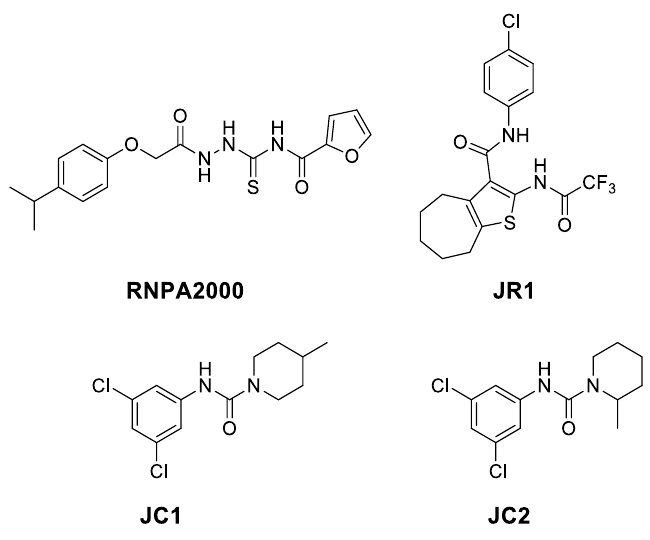
Figure 1. Structure of RNPA2000 , JC1 , JC2 , and JR1 , known RnpA inhibitors.